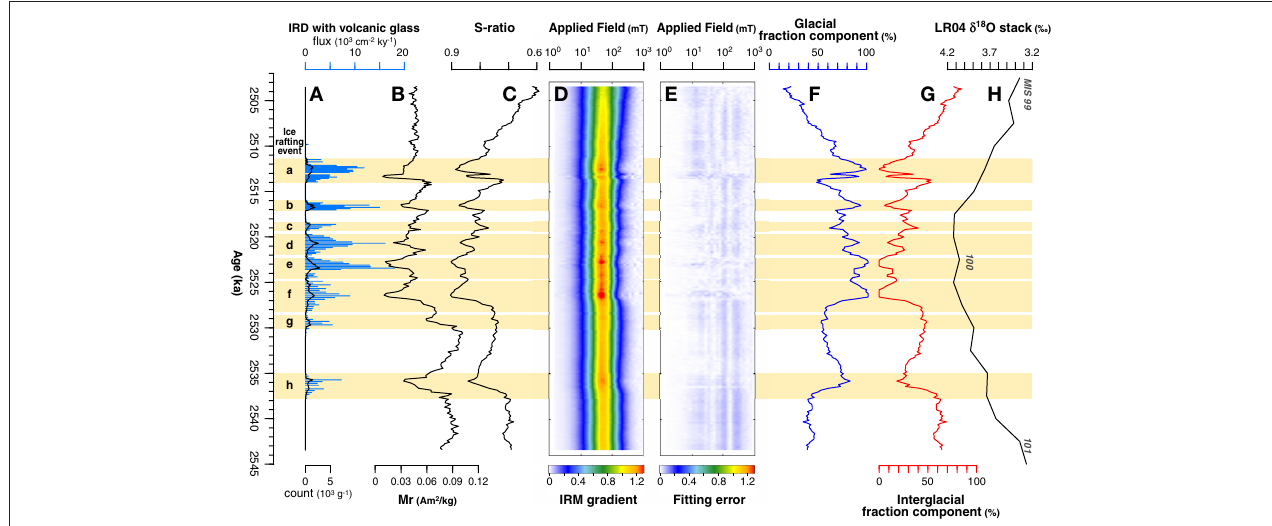
FIGURE 5 | Multi-proxy records of ice-rafting events and bottom current variability during the MIS 100 glacial period from IODP Site U1314. (A) Ice-rafting events shown by count (black curve) and flux (blue bars) of IRD without volcanic glass; (B–G) Bottom current variability shown by magnetic parameters; (H) Global ice volume shown by the LR04 stack ( Lisiecki and Raymo, 2005). Magnetic parameters are (B) saturation remanence ( M r), (C) S -ratio, (D) isothermal remanent magnetization (IRM) gradient curves. In addition, (F) glacial component and (G) interglacial components were calculated from IRM acquisition curves, with (E) absolute values of residual curves in fitting by the two endmember components (see